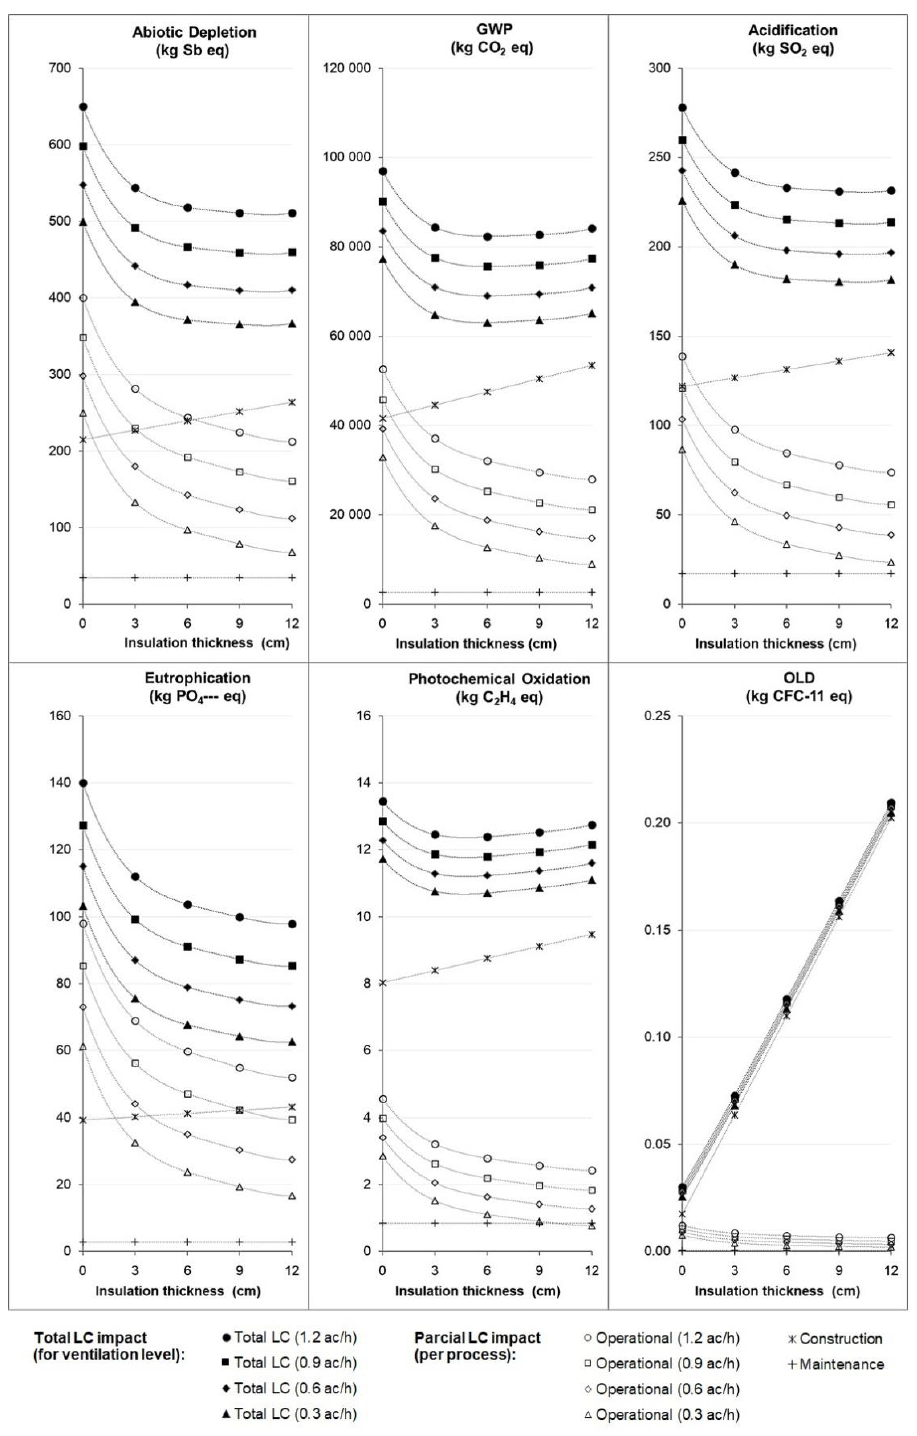
Figure 3. LCIA results for base case house with a heat pump for OP50: ventilation level vs. insulation level.